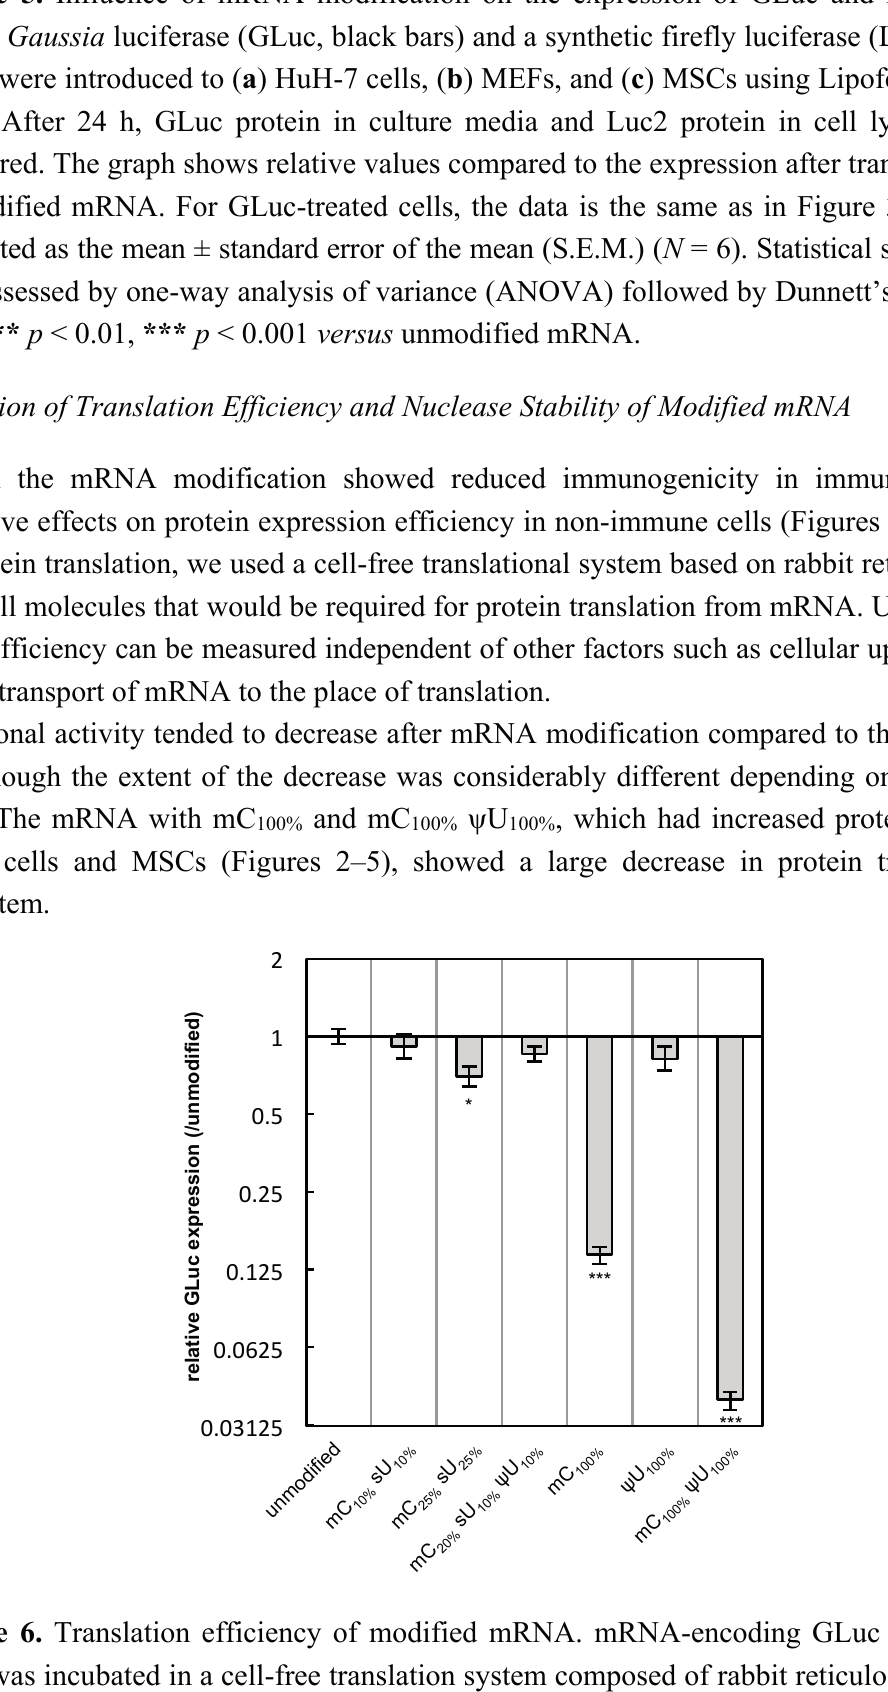
Figure 5. Influence of mRNA modification on the expression of GLuc and Luc2. Two genes, Gaussia luciferase (GLuc, black bars) and a synthetic firefly luciferase (Luc2, white bars), were introduced to ( a ) HuH-7 cells, ( b ) MEFs, and ( c ) MSCs using Lipofectamine™ LTX. After 24 h, GLuc protein in culture media and Luc2 protein in cell lysates were measured. The graph shows relative values compared to the expression after transfection of unmodified mRNA. For GLuc-treated cells, the data is the same as in Figure 3. Data are presented as the mean ± standard error of the mean (S.E.M.) ( N = 6). Statistical significance was assessed by one-way analysis of variance (ANOVA) followed by Dunnett’s test. * p < 0.05, ** p < 0.01, *** p < 0.001 versus unmodified mRNA.